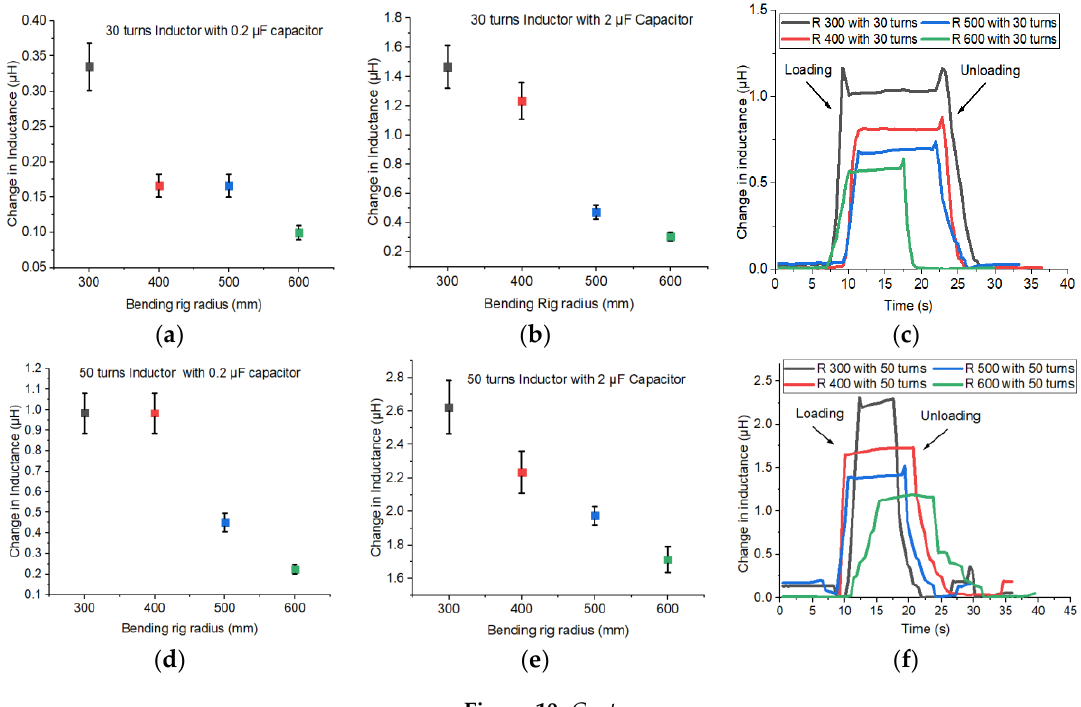
Figure 10. Cont. Figure 10.